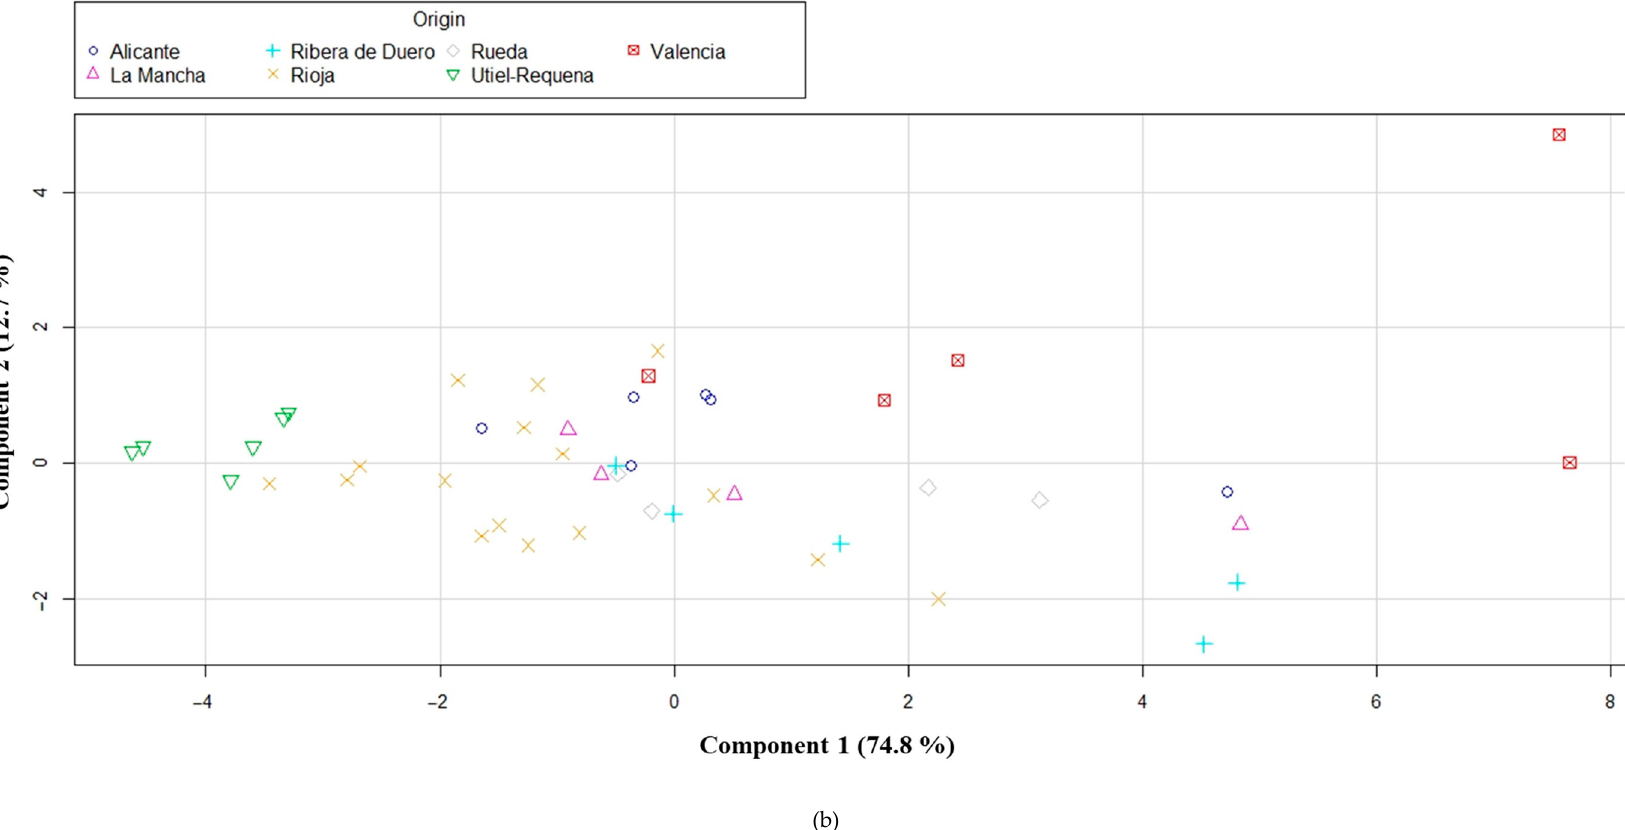
Figure 1. Principal components analysis performed on data expressed as concentration of REEs (Dy, Er, Eu, Gd, Ho, Nd, Pr, Sm, Tb, Tm and Yb) in wines from different designations of origin. ( a ) Loading plot; ( b ) score plot.